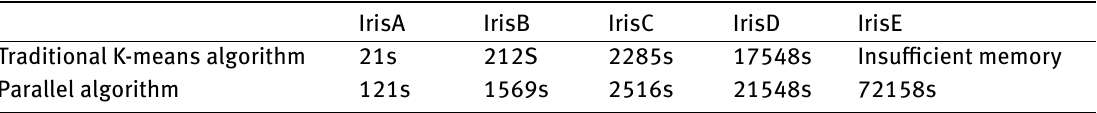
Table 3: Comparison of single-machine operation time